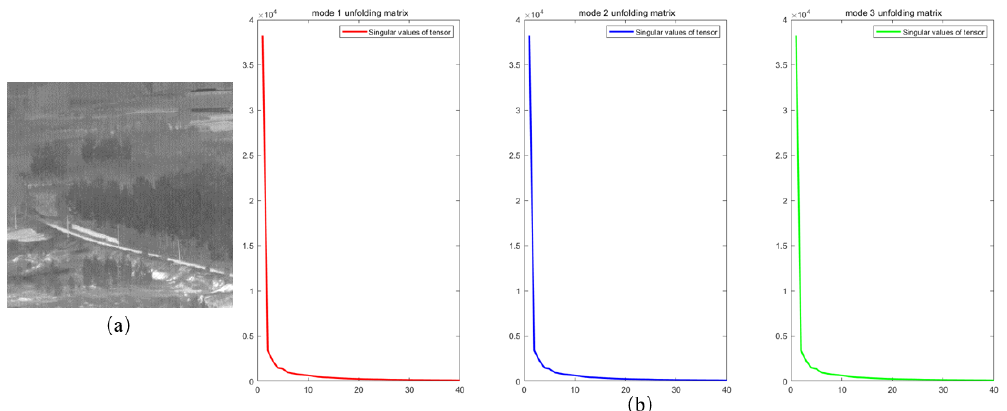
Figure 2. Illustration of the low-rank property of the unfolding matrices. ( a ) is the original background image, and ( b ) is the three sets of singular values obtained by expanding the front slice, horizontal slice, and side